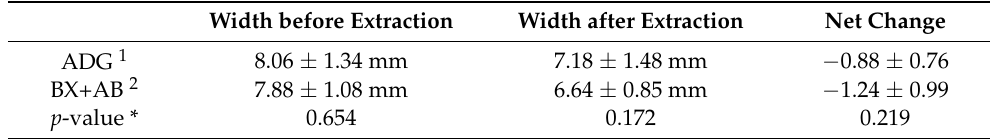
Table 5. CBCT analysis of alveolar ridge dimensional